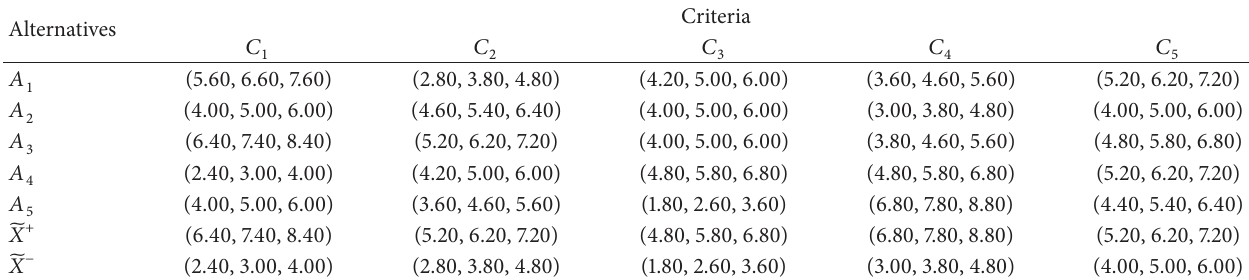
Table 8: Aggregated fuzzy performance ratings of the alternatives.